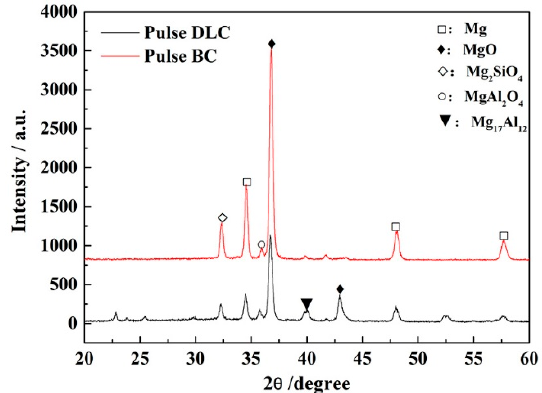
Figure 5. The XRD patterns of the MAO coatings using pulsed bipolar current and the pulsed with a discharge loop current power supply mode.